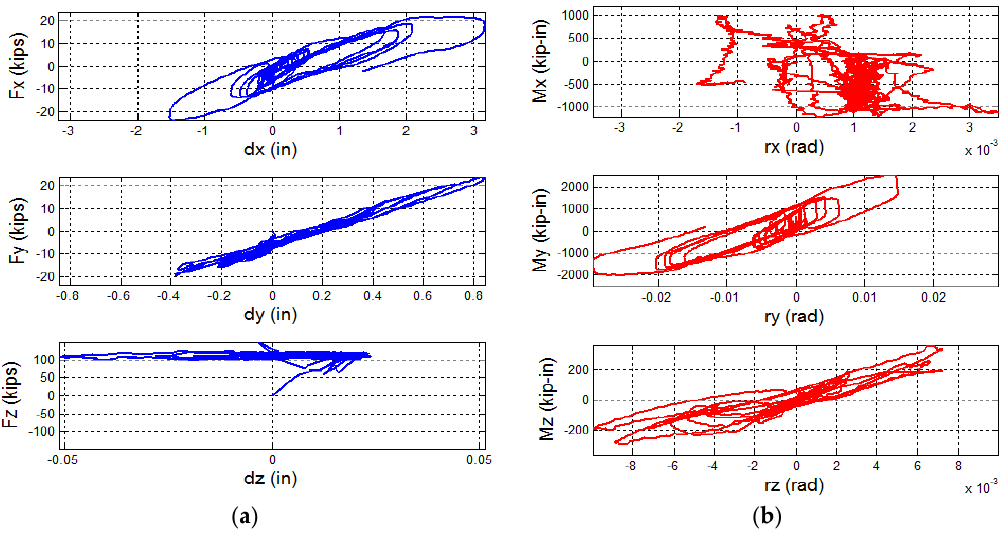
Figure 7. Force-displacement and moment-curvature relationships in the x -, y - and z -directions. ( a ) Force-displacement relationships; ( b ) Moment-curvature relationships.